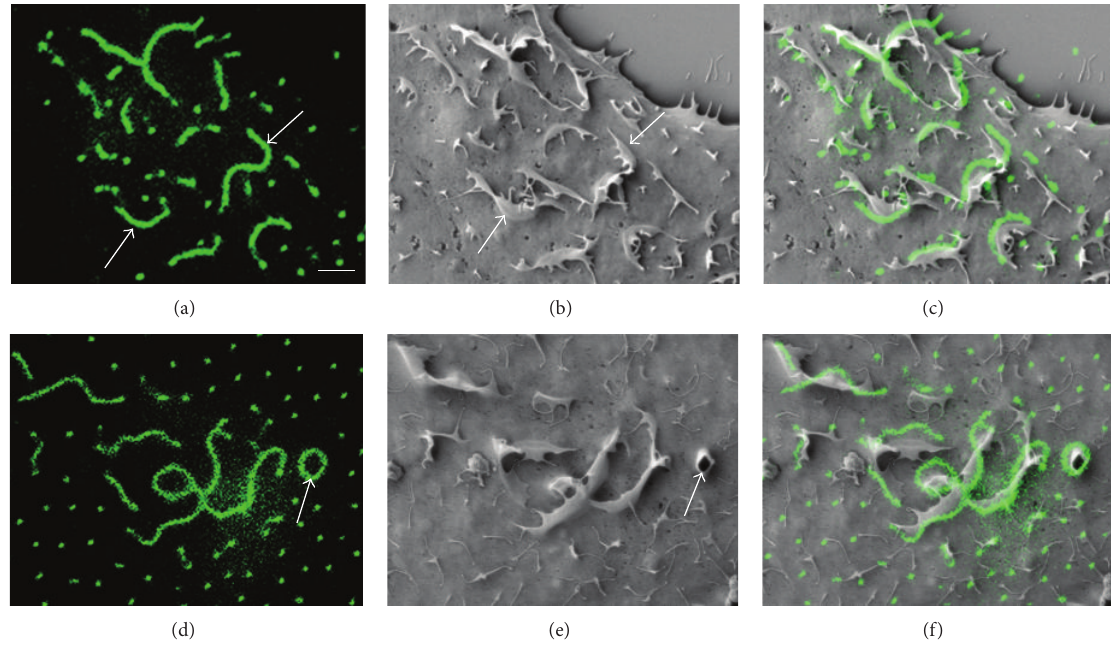
Figure 4: Ultrastructure of GFP-HAS3-positive dorsal ruffles. 2D confocal images showing the dorsal GFP-HAS3 signal are shown in (a) and (d) and corresponding SEM images in (b) and (e). Merged images are shown in (c) and (f), respectively. Many of the dorsal ruffles were linear or curved in shape (a) and provided a basis for several thinner protrusions (arrows in (b)). Occasionally, circular ruffles were detected (arrows in (d)-(e)). Scale bar 2 𝜇